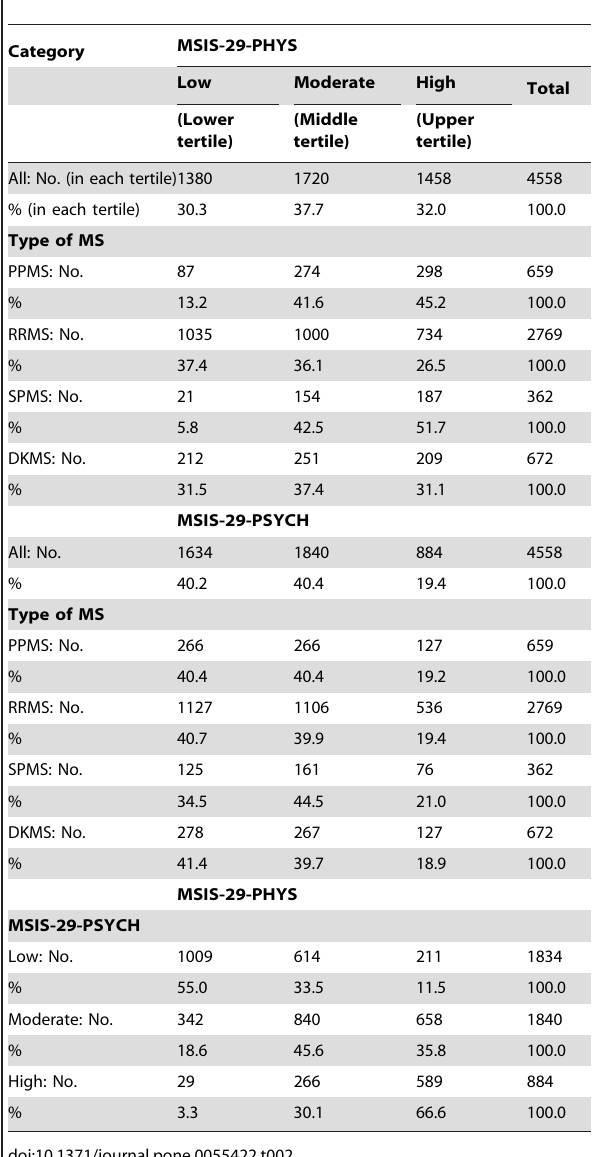
Table 2. Frequencies of low, moderate and high MSIS-29 scores among the